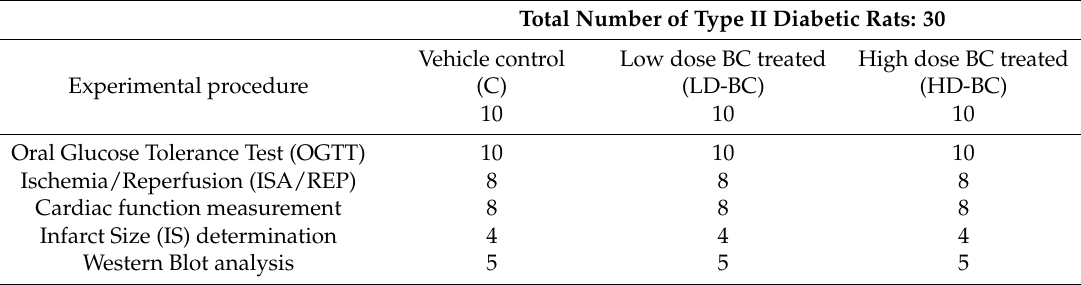
Table 1. The number of hearts used in the different